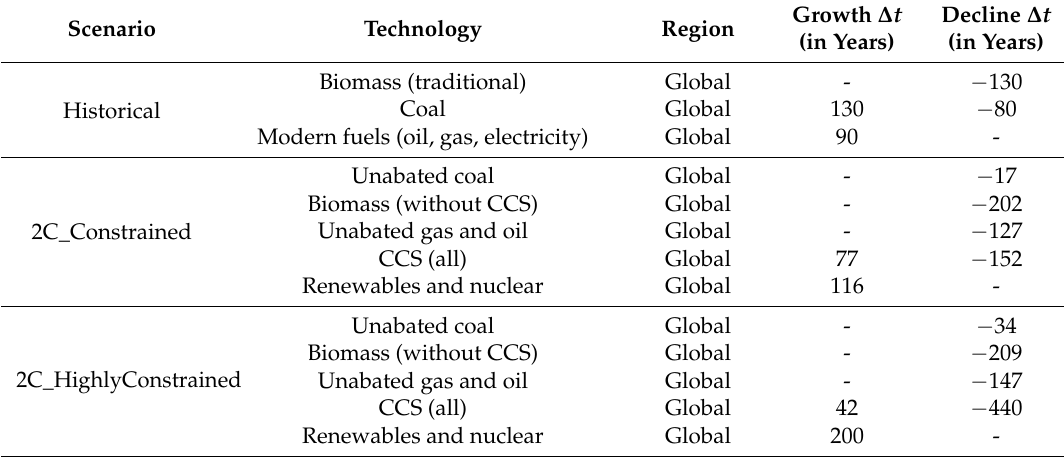
Table 8. Values of ∆ t in years for historical transitions [20] and TIAM-Grantham